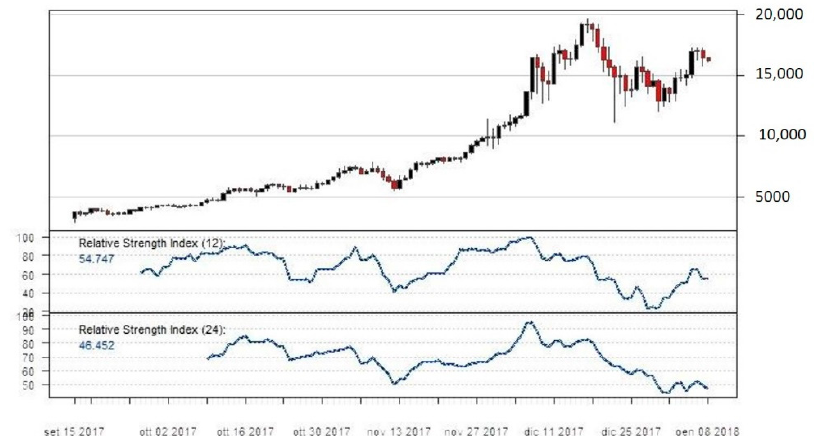
Figure 6. RSI12 ( top panel) and RSI24 ( bottom panel) on daily Bitcoin price series.